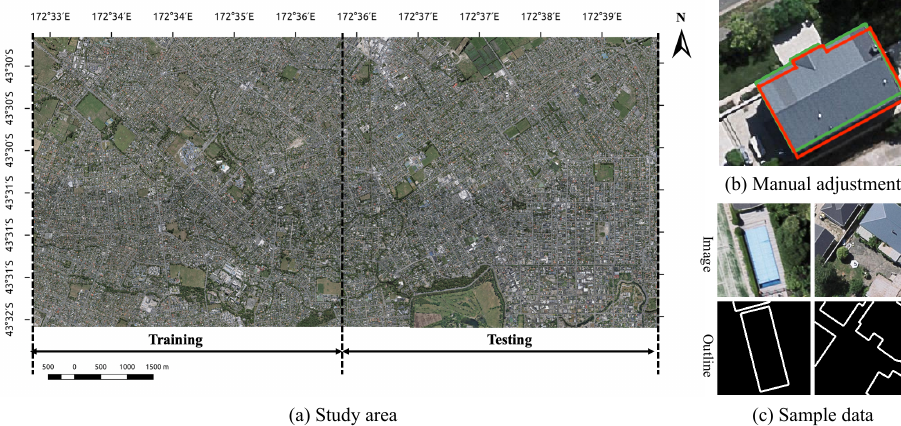
Figure 1. ( a ) Aerial imagery of the study area ranging from 172 ◦ 33 (cid:48) E to 172 ◦ 40 (cid:48) E and 43 ◦ 30 (cid:48) S to 43 ◦ 32 (cid:48) S, encompassing approximately 32 km 2 . ( b ) Manual adjustment of provided annotation (e.g., from Red to Green polygon). ( c ) Sample pairs of the extracted